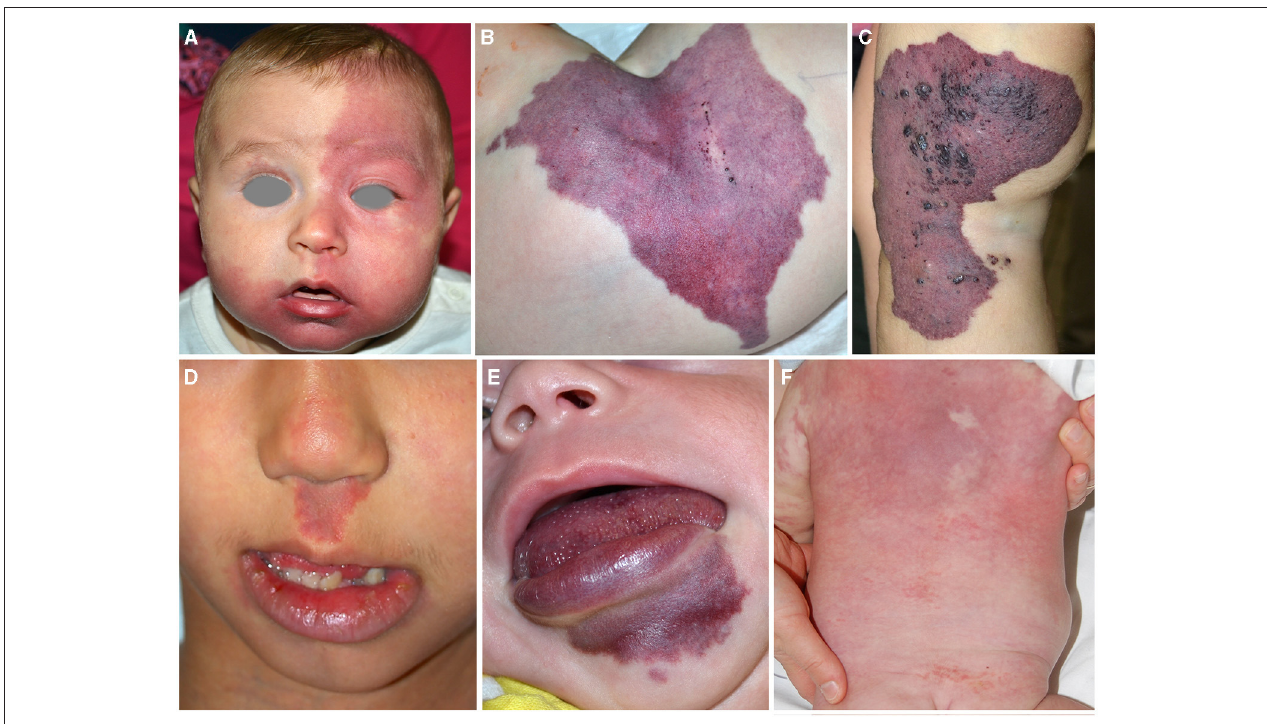
FIGURE 1 | Capillary malformation involving the frontal area in an infant affected with Sturge Weber syndrome (A) . Violaceous patch of the hip in an infant affected with CLOVES syndrome. Crusted vesicles are present on the surface of the stain indicating the presence of a lymphatic component (B) . Capillary–venous–lymphatic malformation of the thigh in a child affected with Klippel Trenaunay syndrome (C) . Capillary malformation of the philtrum in a child affected with megalencephaly-capillary malformation (D) . Capillary malformation of the lower lip in an infant affected with CLAPO syndrome (E) . Reticulated and diffuse capillary malformation with blurred margins on the trunk in a 3-month-old infant affected with diffuse capillary malformation with overgrowth (F)